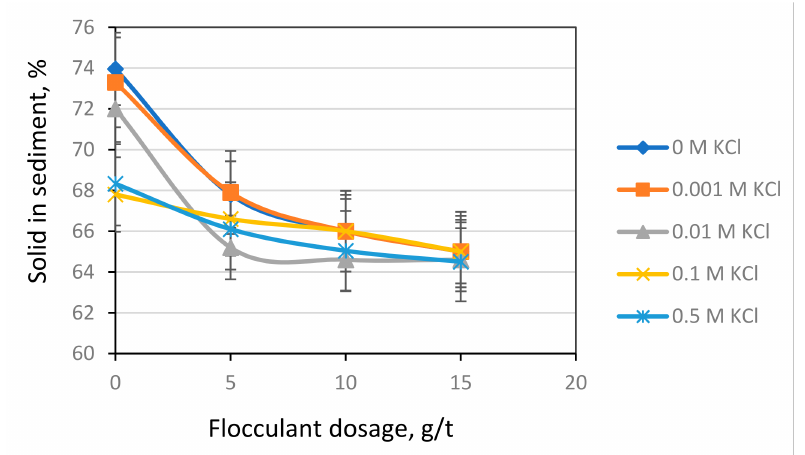
Figure 12. Percentage of solid in sediment with Magnafloc 338 flocculant, with industrial